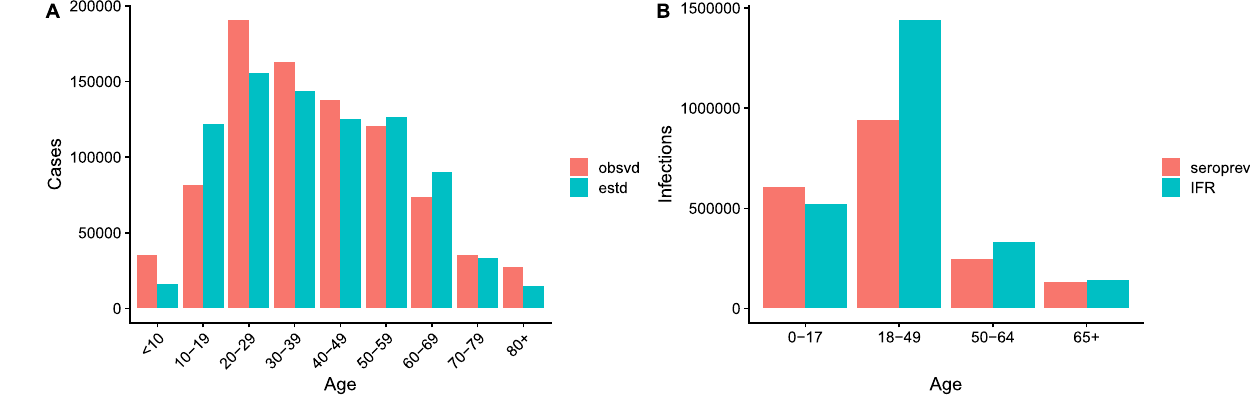
Figure 2. Model calibration. ( A ) Age distributions of cumulative numbers of confirmed cases in California Department of Public Health data (red) and clinical cases estimated from the model (turquoise) up to October 22, 2020. ( B ) Age distributions of infections estimated from seroprevalence estimates for California up to October 8–13, 2020, from CDC nationwide commercial lab seroprevalence data (red) 28 and estimated from the model using the infection fatality rate (IFR) from 26 recalibrated for California such that the total numbers of cases in the distributions in ( A ) match.